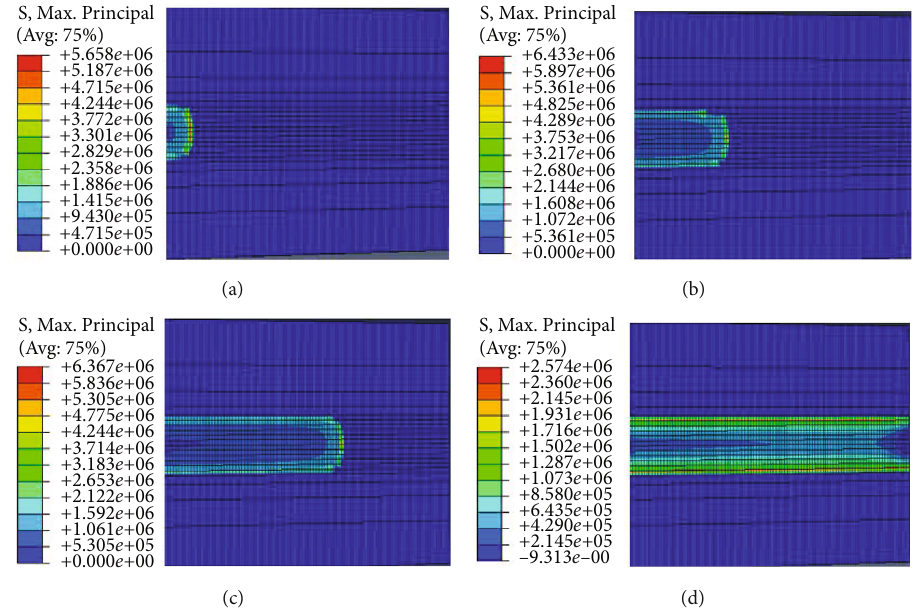
Figure 11: Development of height and length of hydraulic fracture at di ff erent times: (a) 20 steps, (b) 60 steps, (c) 150 steps, and (d) 300